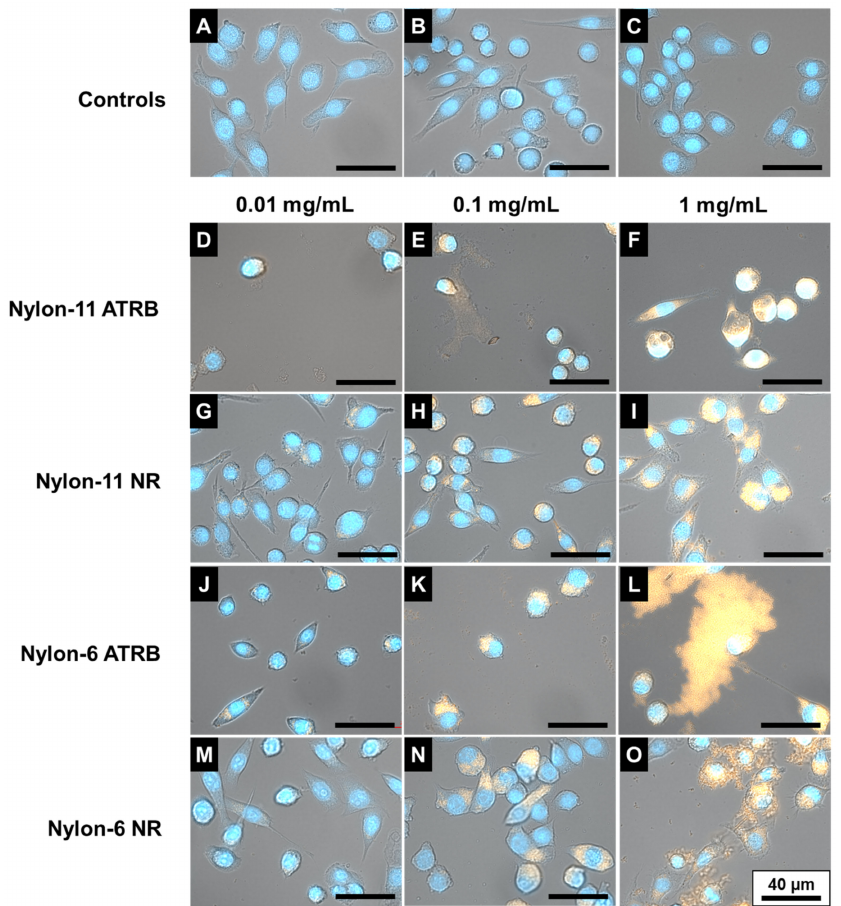
Figure 6. Overlay of bright-field and fluorescence microscopy images of RAW 264.7 cells exposed to the media control only ( A ); PVA vehicle control ( B ); water vehicle control ( C ); nylon-11 ATRB NPs at 0.01 mg/mL ( D ), 0.1 mg/mL ( E ), and 1 mg/mL ( F ); nylon-11 NR NPs at 0.01 mg/mL ( G ), 0.1 mg/mL ( H ), and 1 mg/mL ( I ); nylon-6 ATRB NPs at 0.01 m/mL ( J ), 0.1 mg/mL ( K ), and 1 mg/mL ( L ); and nylon-6 NR NPs at 0.01 mg/mL ( M ), 0.1 mg/mL ( N ), and 1 mg/mL ( O ). Cellular nuclei were stained with DAPI (blue) and the nylon NPs are shown in orange. Scale bar in each panel represents 40 µ